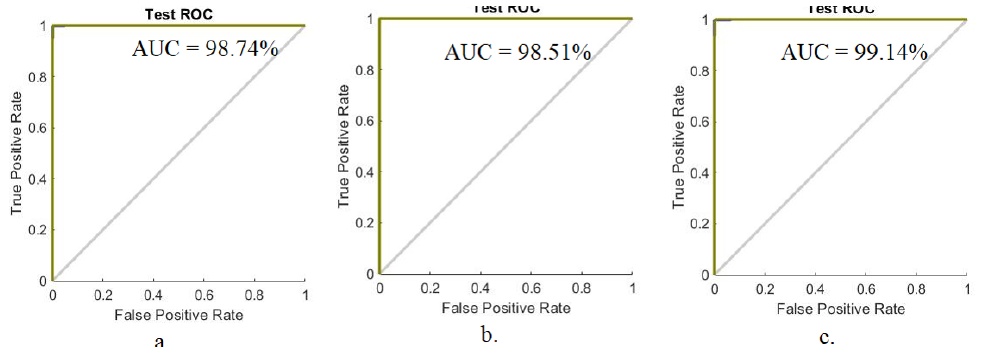
Figure 17. ROC of ANN on hemorrhage dataset based on hybrid features by ( a ) GoogLeNet and GLCM + LBP, ( b ) ResNet-50 and GLCM + LBP and ( c ) AlexNet and GLCM + LBP.